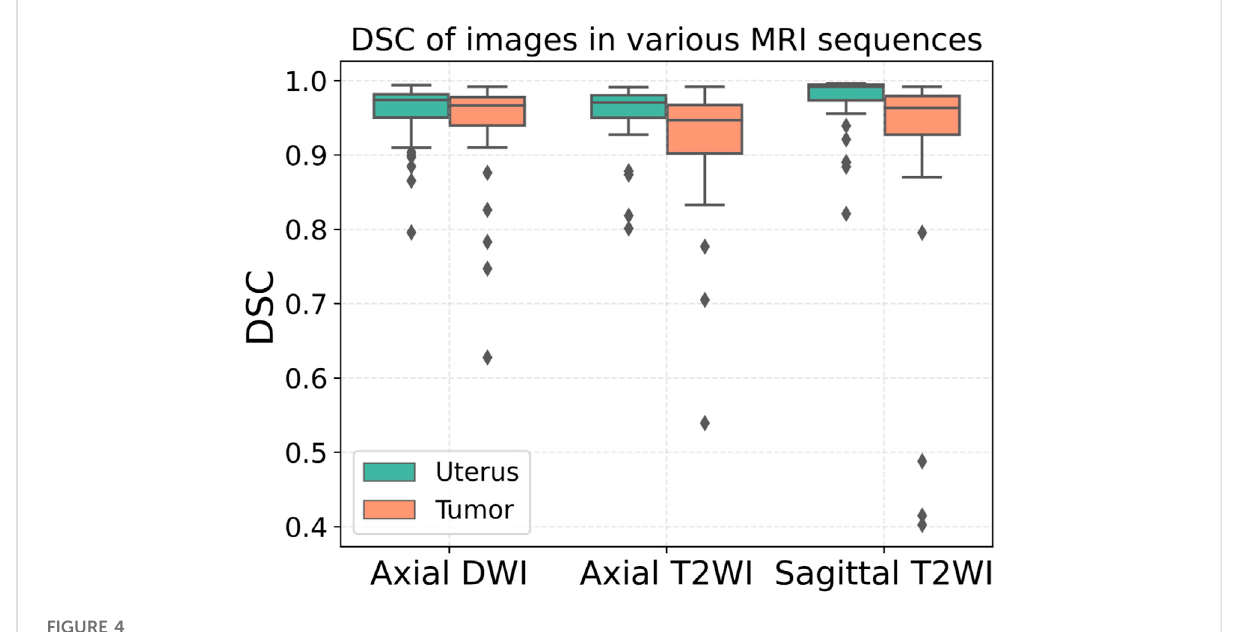
FIGURE 4 DSCs of the segmented uterus and tumor.